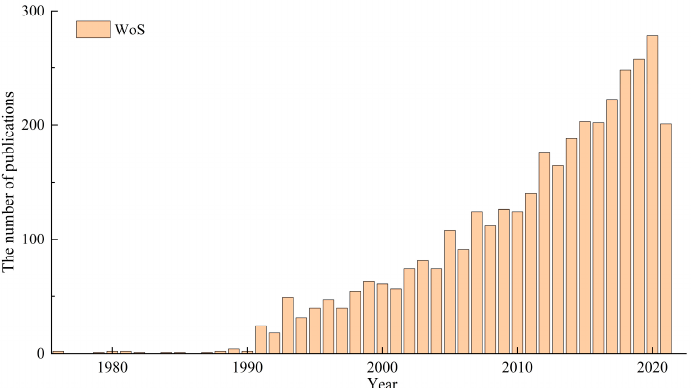
Figure 1. The number of publications. Table 1. Top 10 countries.